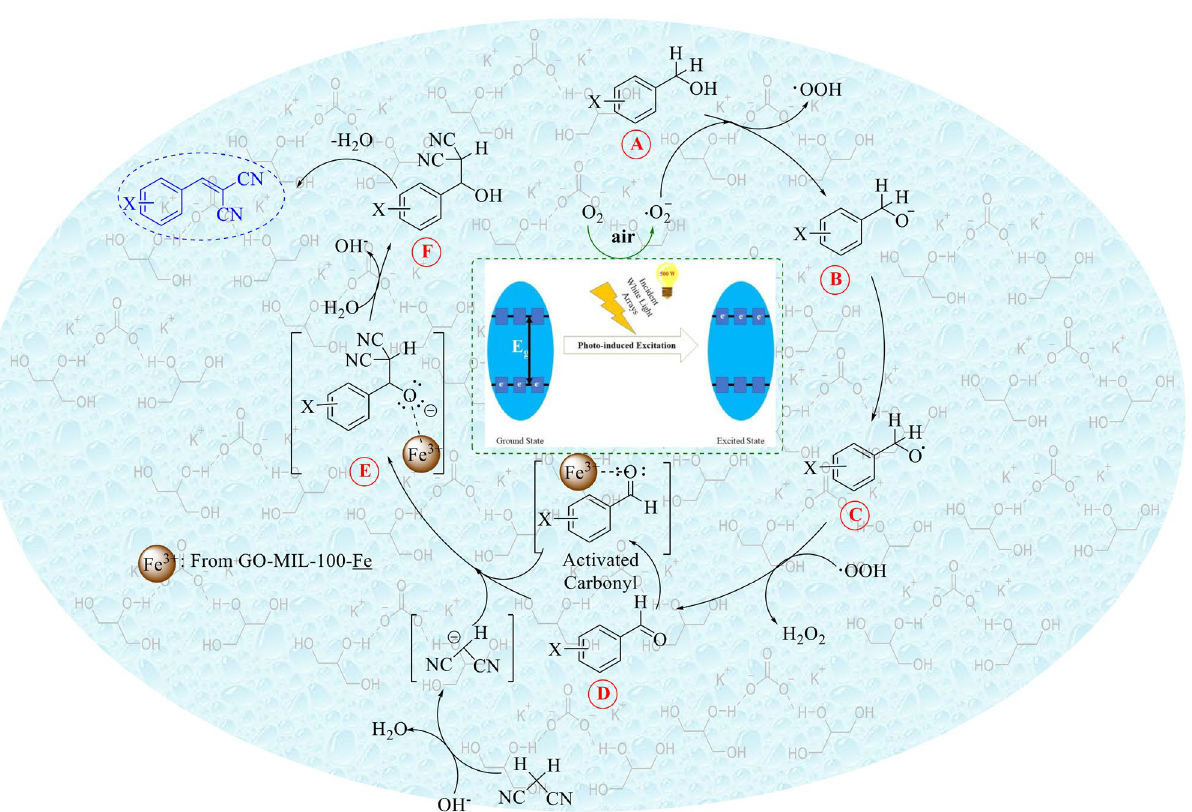
Figure 7. Proposed mechanism for the current